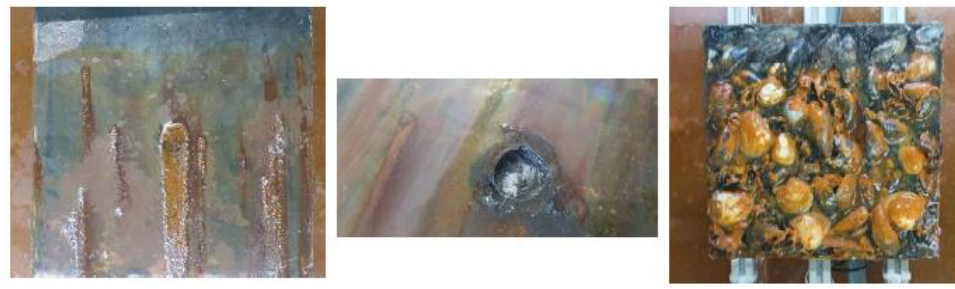
13 of 18 Figure 12. ( a ) Corrosion damage on the baseplate; ( b ) Localisation results on the baseplate. 4.2. Corrosion-Induced Acoustic Emissions on Marine Growth Covered Plate Figure 13 shows the corrosion damage for the marine growth covered plate at the end of the experiment. It can be seen that the major corrosion damage took place at the exposed surface. Compared to the base plate, better isolation was achieved with epoxy paint and showed more resilience towards the corrosive environment. However, small